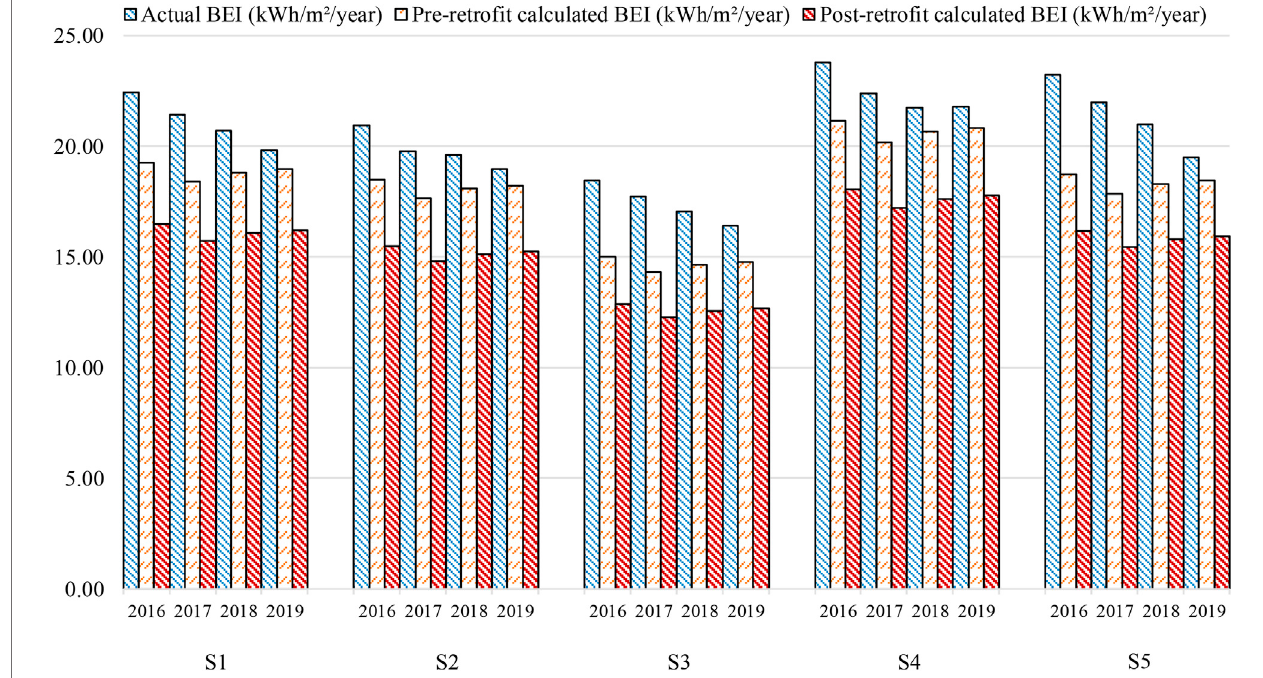
FIGURE 2 | Summary of actual Building Energy Index (BEI), pre-retro fi t calculated BEI, and post-retro fi t calculated BEI in kWh/m 2 /year in four-year duration (2016 – 2019).